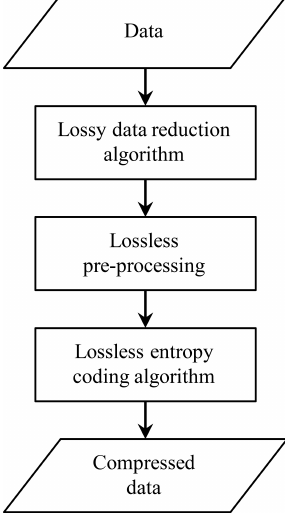
Figure 1. Compression chain showing the data reduction, prepro- cessing and lossless coding